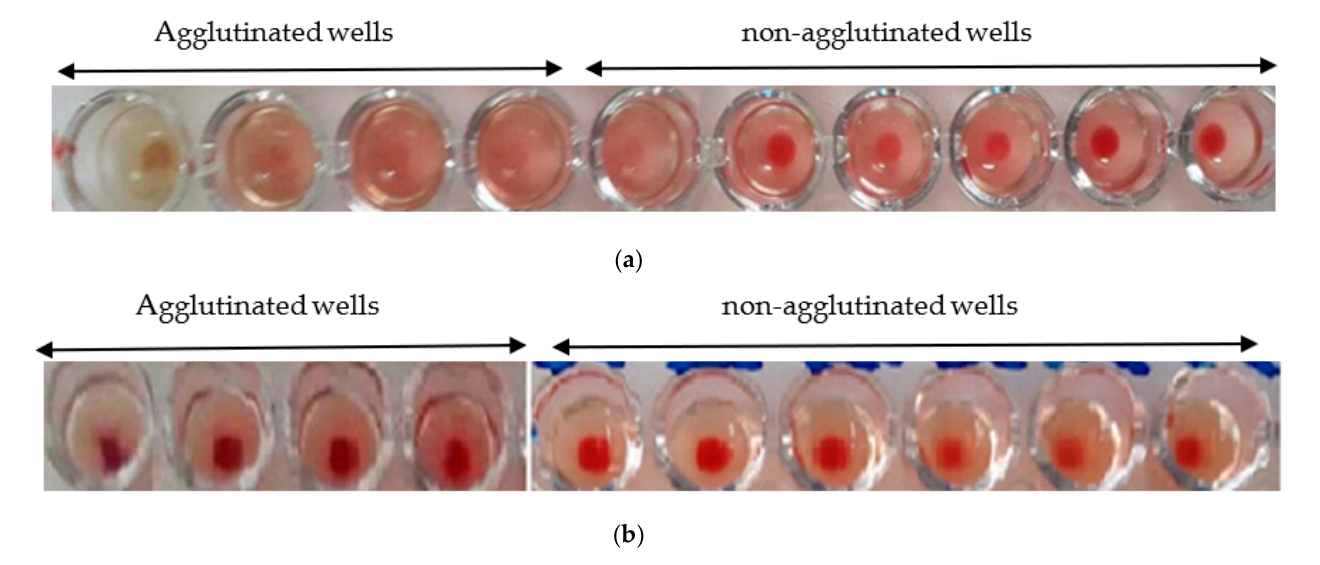
Figure 6. ( a ) Hemagglutination limit of Nigella sativa : observation with the naked eye; ( b ) hemagglutination limit of Lepidium sativum : observation with the naked eye.